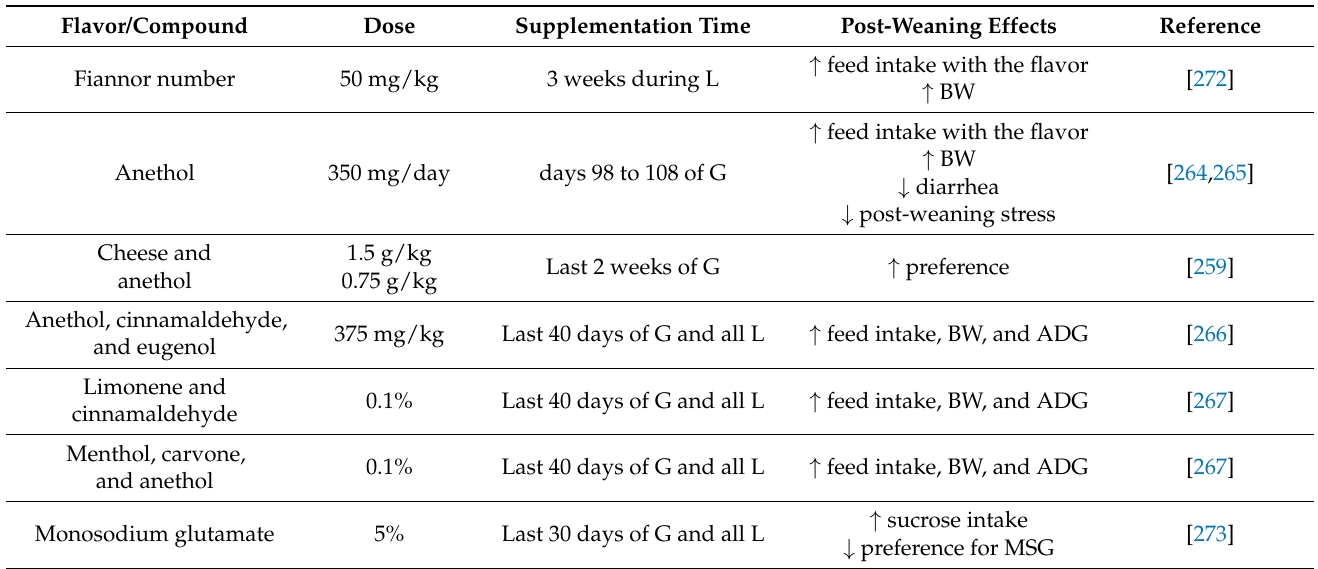
Table 5. Effects of prenatal and postnatal exposure of different flavors or compounds present in the sow’s feed. Flavor/Compound Dose Supplementation Time Post-Weaning Effects